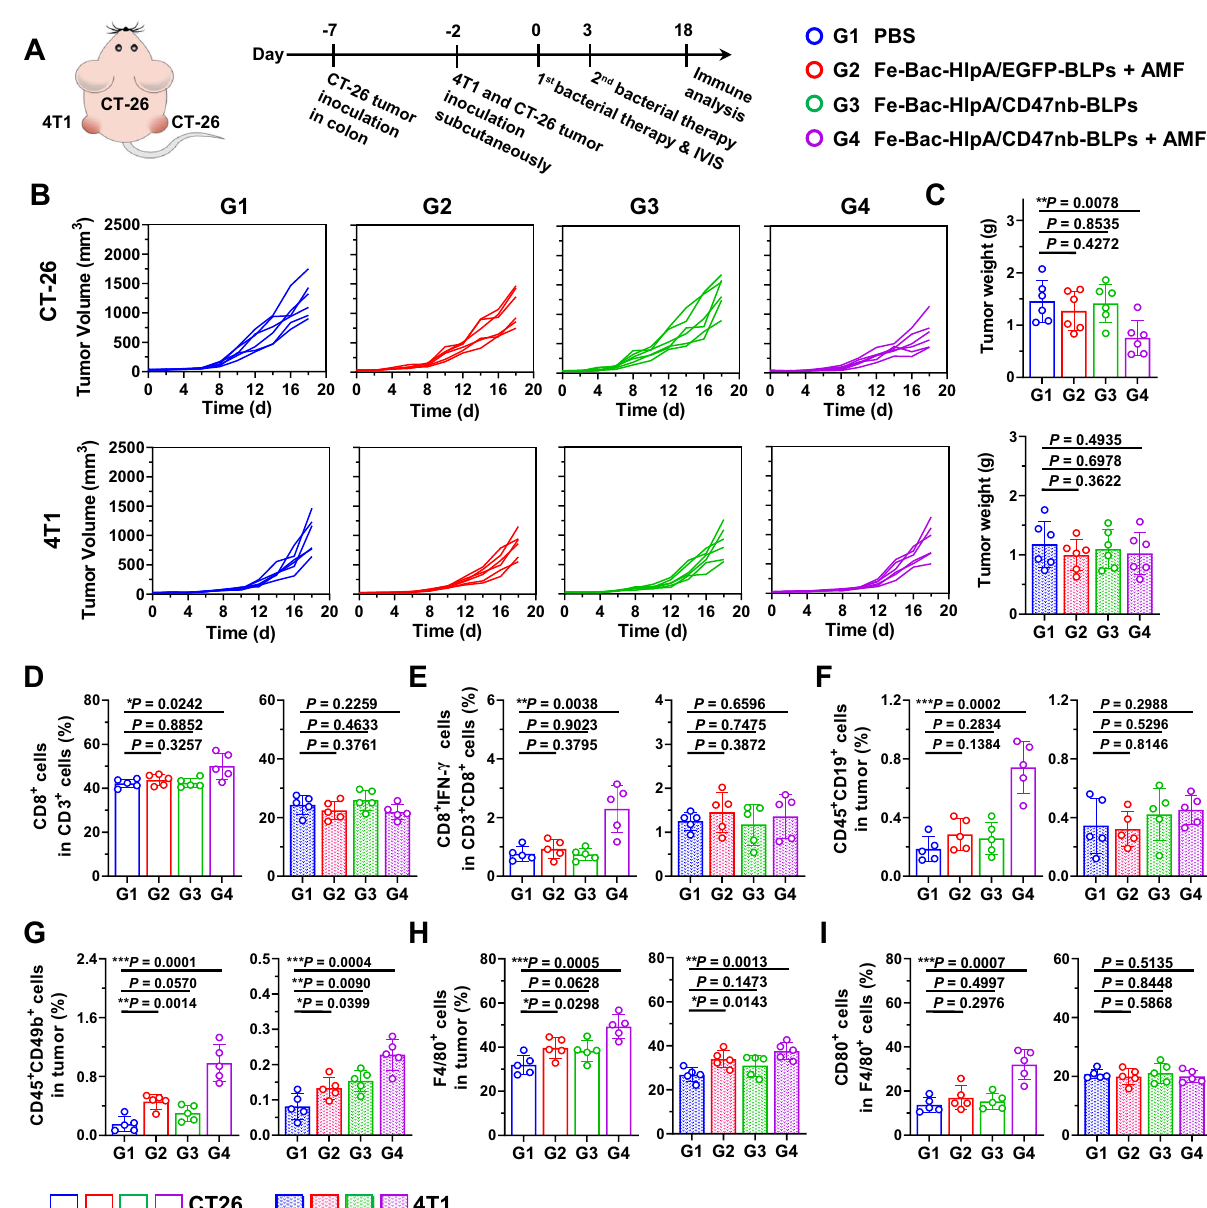
Fig.8|AbscopaleffectoftheimmunotherapyofAMF-Bac.A Schemeandgroups ofinvivotherapytoevaluatetheabscopaleffect.BALB/cmicewereinoculatedwith CT-26 cells in the colon on day -7, and subcutaneously inoculated with CT-26 and 4T1 cells in the right and left hind limb, respectively, on day -2. The mice were treated with engineered bacteria (1×10 8 CFU) by colon-speci fi c administration on days 0 and 3, followed by AMF treatment (310kHz and 23.8kA/m) for 80min at 24h after colon administration. Tumors were collected for fl ow cytometry on day 18. B Change in tumor volume of the subcutaneous CT-26 and 4T1 xenografts (n=5). C Tumor weight of the subcutaneous CT-26 and 4T1 xenografts measured on day 18 ( n =5 mice). D , E Flow cytometry analysis of the percentages of tumor-